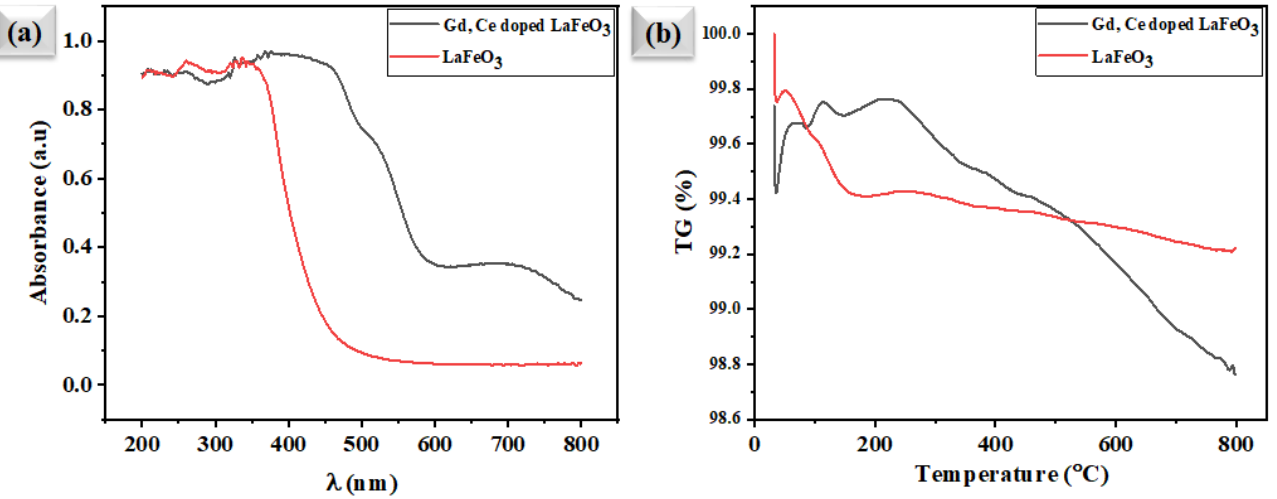
Figure 6. ( a ) The UV-visible spectra of LaFeO 3 and LaFe 0.8 Gd 0.1 Ce 0.1 O 3- δ and ( b ) thermogravimetric analysis of LaFeO 3 and LaFe 0.8 Gd 0.1 Ce 0.1 O 3- δ cathode, respectively. analysis of LaFeO 3 and LaFe 0.8 Gd 0.1 Ce 0.1 O 3- δ cathode,